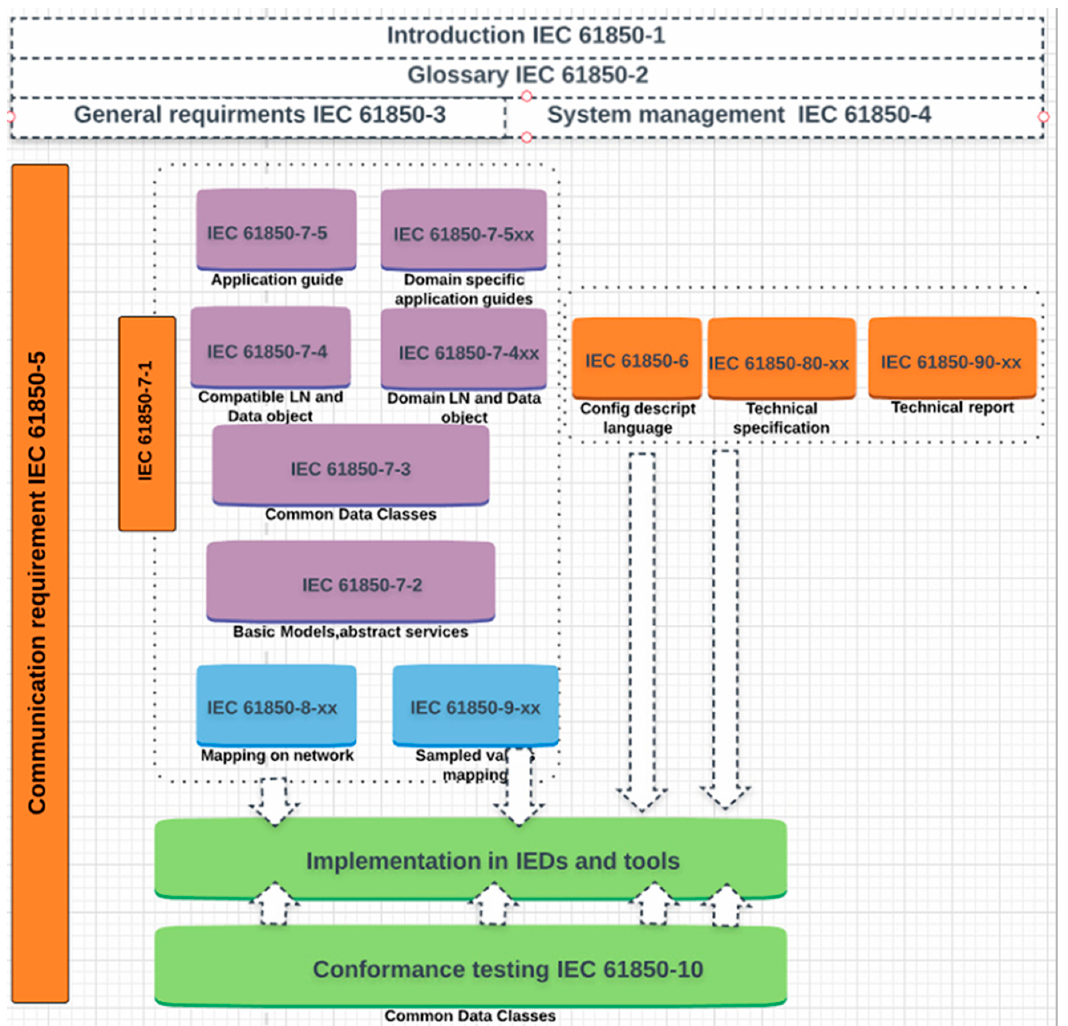
Figure 1. IEC 61850 structure.